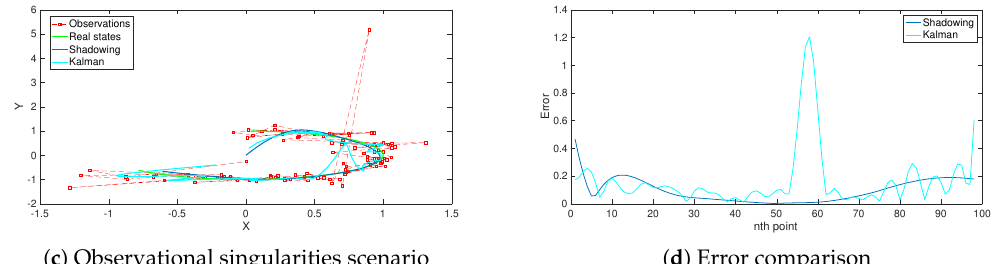
Figure 2. The superiority of the shadowing filter tracking methodology over a sequential filter methodology (Kalman filter). Error correlation has been taken into account in ( a ) and ( b ), while the singularity scenario is presented in ( c ) and ( d ). The shadowing filter shows obvious superiority, especially where error correlation increases the nonlinearity of the system far from the reference point at the origin in the first scenario and around the singular records in the second scenario. Note that the large error of the shadowing filter estimates at the beginning of the trajectory is expected, as explained in previous investigations